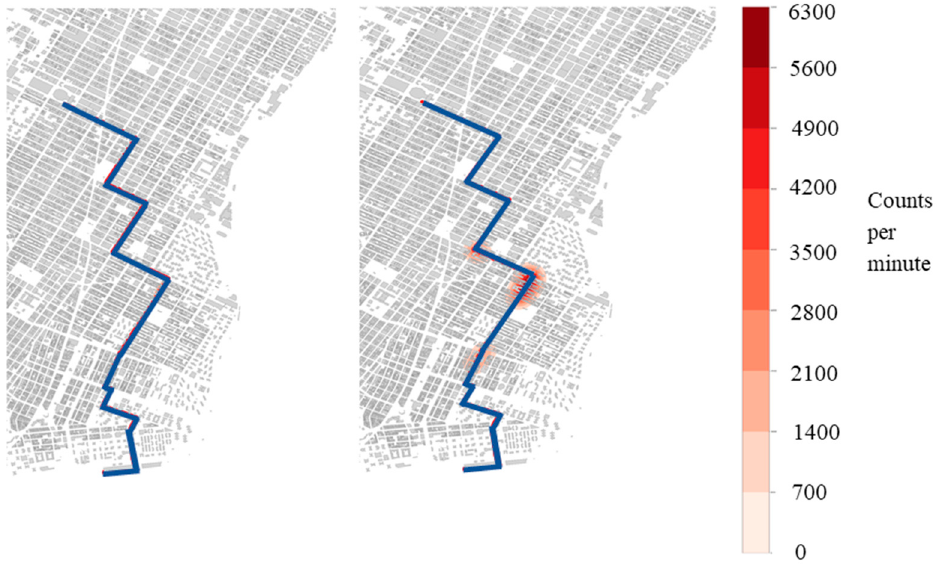
Figure 3. Detection heat map. Maps show the counts per minute above background detected for a single route for a 400-vehicle mobile detector array of a 0.1 Ci Co-60 ( left —case 7) and a 0.5 Ci Co-60 ( right —case 10) source moving at 2 m/s.